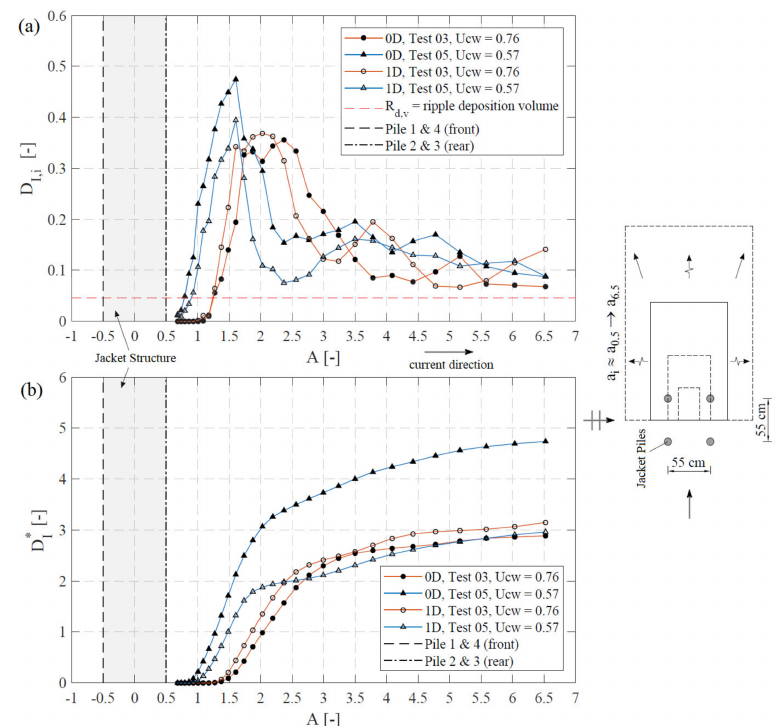
Figure 10. Incremental volume depth D I , i ( a ), as well as the cumulative integral of the net deposition ( b ) as a spatial function of the distance to the center of the structure. Additional graphical subset to visualize the arrangement of interrogation areas ( a i ) on the lee side of the foundation